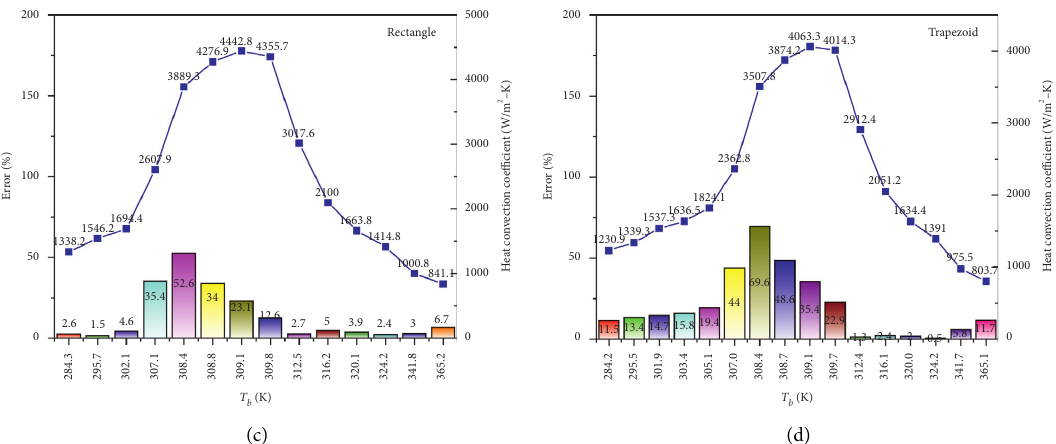
Figure 11: The relative error between CFD and Jackson correlation analysis results for the cooling mode: (a) circular; (b) semicircular; (c) rectangle; and (d)